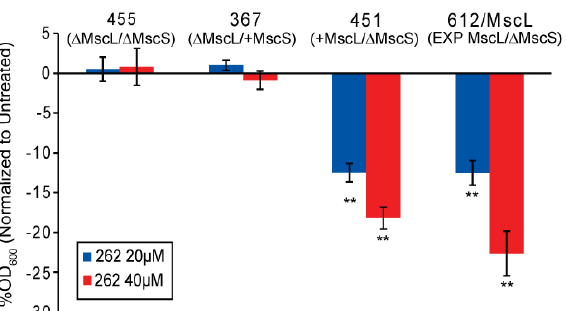
Figure 3. Compound 262 affects cultures with endogenous levels of expression of E. coli MscL. Cell lines used were indicated with endogenous levels of expression of MscL or MscL expressed in trans (EXP MscL), treated with compound 262 overnight at either 20 µM (blue) or 40 µM (red). The percent changes in OD 600 normalized to untreated cultures are shown (n = 3). ** p < 0.005 by a 2-tailed, homoscedastic t -test when compared to MJF455 ( Δ MscL and Δ MscS) at the same concentration.